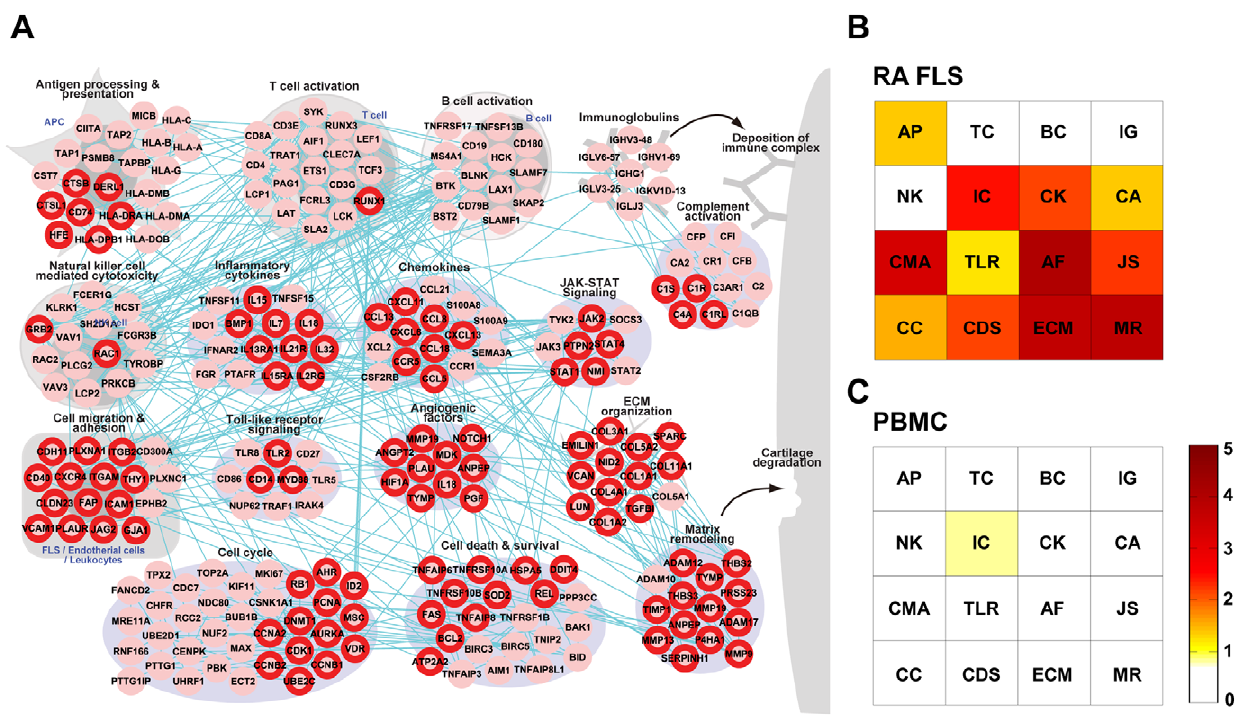
Figure 2. A RA-perturbed network in the RA synovium and signatures of FLS and PBMC in the RA tissue network. A) A RA-perturbed network describing RA associated cellular processes in which 242 up-regulated RAGs are involved and their interactions. The network nodes are arranged into sixteen modules based on their GOBPs and the KEGG pathways that they belong to. The nodes with red boundary represent DEGs in RA FLS. B) and C) Module enrichment scores (see text for definition) representing the significances of overlaps of the DEGs in RA FLS (B) or PBMC (C) with the genes belonging to the sixteen network modules. See text for detailed discussion. AP=Antigen processing & presentation; TC=T-cell activation; BC=B-cell activation; IG=Immunoglobulins; CA=Complement activation; NK=Natural killer cell mediated cytotoxicity; IC=Inflammatory cytokines; CK=Chemokines; CMH=Cell migration & adhesion; TLR=Toll-like receptor signaling; AF=Angiogenic factors; JS=JAK-STAT signaling; CC=Cell cycle & DNA repair; CDS=Cell death & survival; ECM=ECM organization; MR=Matrix remodeling.